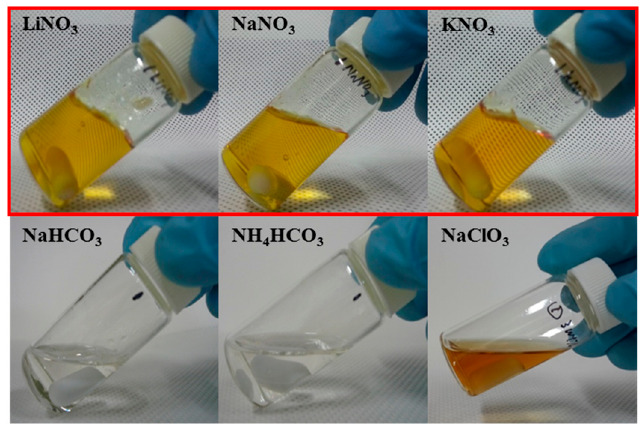
Figure 1. Gelation behaviors of silk fibroin (SF)/formic acid solution according to the addition of salts. The red parts indicate gelated SF solutions according to the addition of nitrate-type salts.